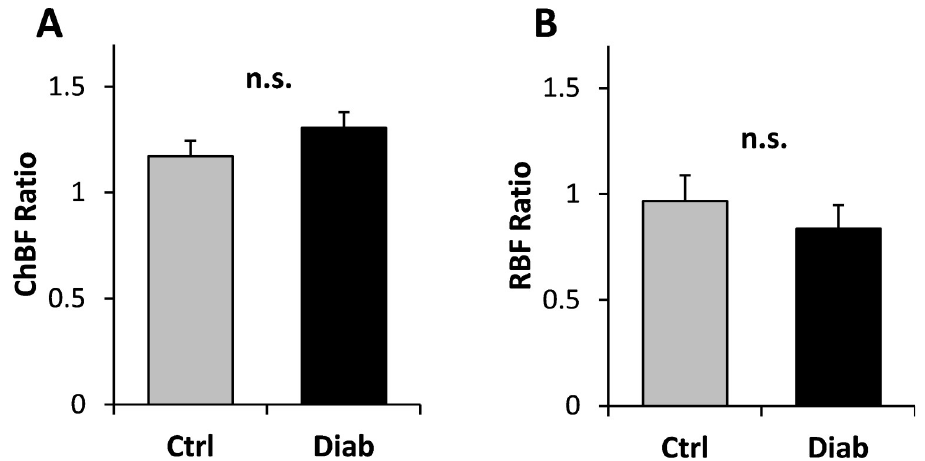
Fig 6. Ratios of hypercapnia to air values of choroidal blood flow (ChBF) (A) and retinal blood flow (RBF) (B) from the nasal region for Ctrl and Diab mice determined using MRI. Ratios were not significantly different between Ctrl and Diab (n.s.). Error bars show standard errors.